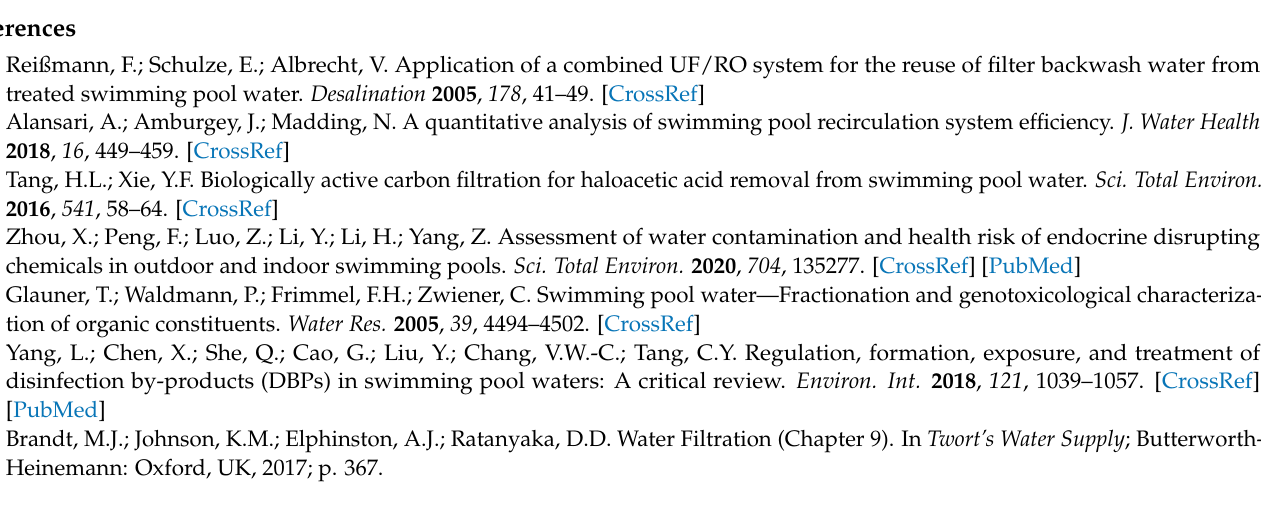
installation, Table S4: Microbiological requirements to be met by water in swimming pools, Table S5: Physicochemical requirements to be met by water in swimming pools, Table S6: Summary of the analyzed microbiological parameters and test methods, Table S7: Summary of the analyzed physicochemical parameters and test